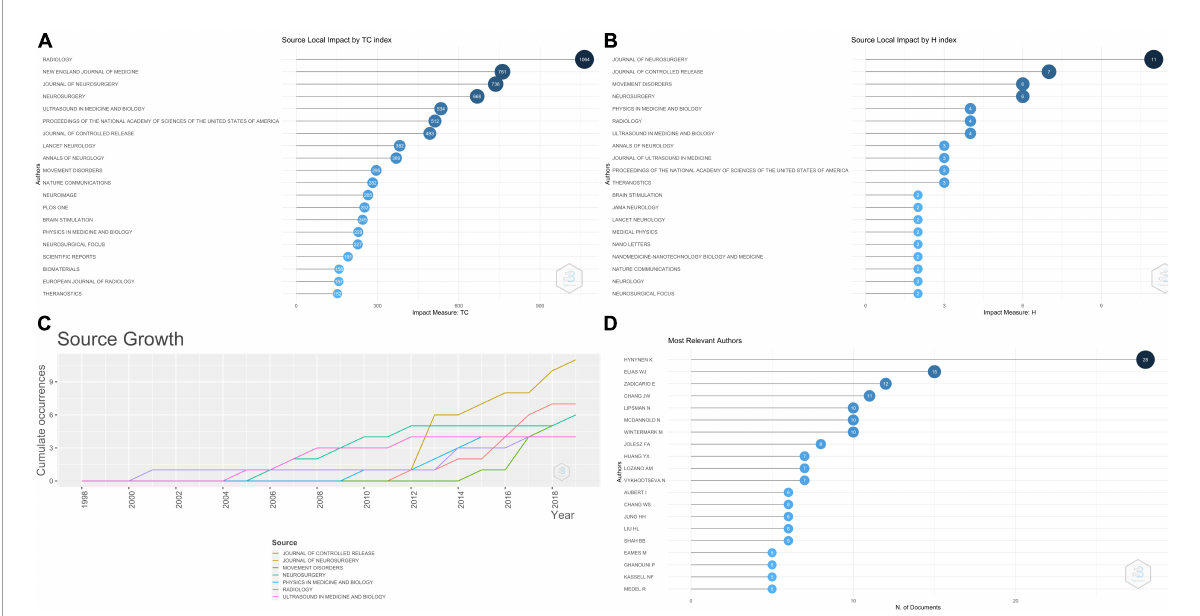
FIGURE2 (A) Graph showing the top 20 journals with maximum impact in terms of total citations received by the articles included in the analysis. (B) Graph showing the top 20 journals with maximum impact in terms of H-index of the articles included in the analysis. (C) Line graph showing the “Source growth,” i.e., the cumulative number of articles published in the top seven journals. (D) Graph showing the number of articles among the top 100 cited articles on MRgFUS published by different